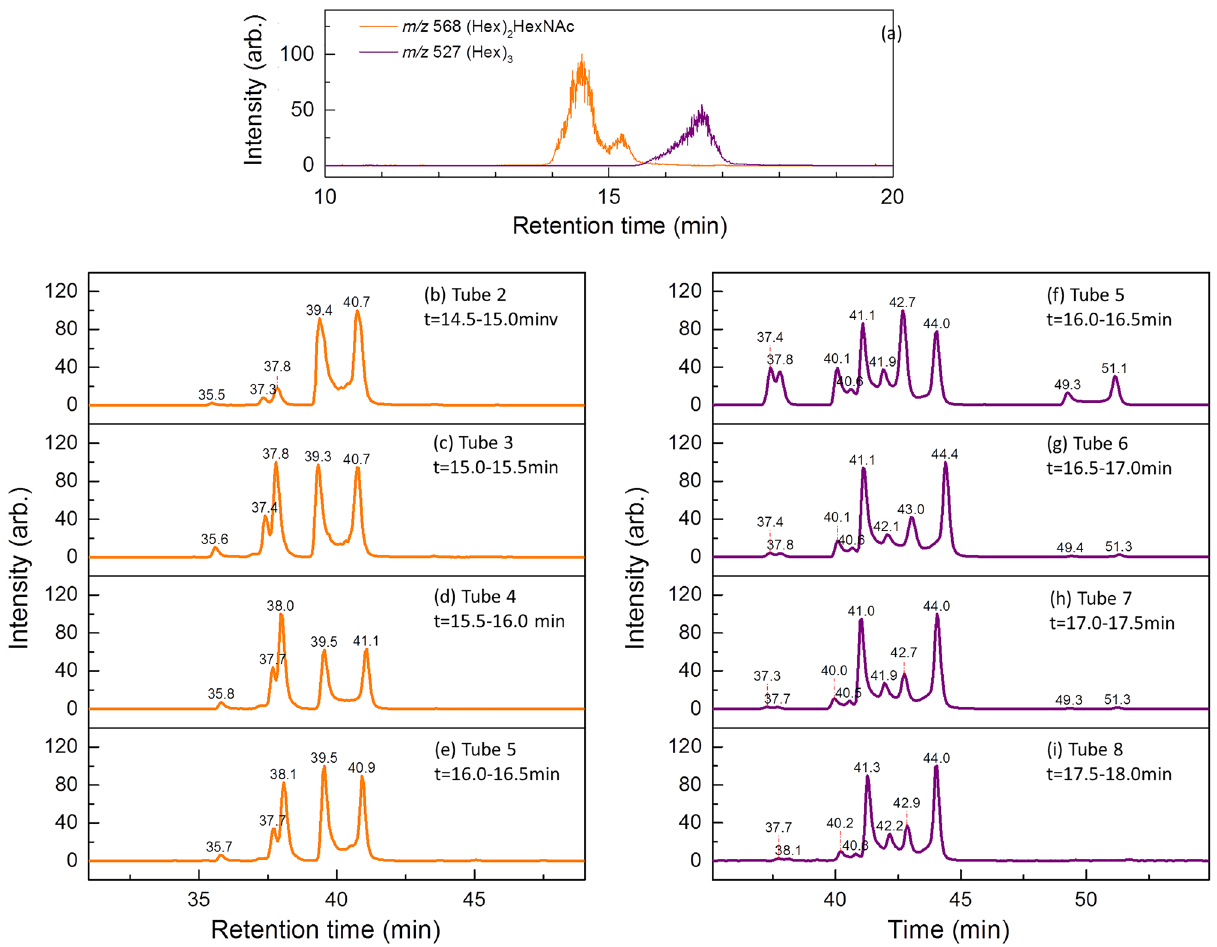
Figure 5. ( a ) Chromatograms of ions m/z 527, (Hex) 3 and 568, (Hex) 3 HexNAc, separated by HPLC with amide-80 column of bovine milk. ( b–e ): Chromatograms of ion m/z 568. ( f–i ): Chromatograms of ion m/z 527. In ( b–i ), the isomers in each fraction collected from the eluents of amide-80 column were separated by HPLC with PGC column. The duration that each fraction collected from the eluents of amide-80 column, corresponding to retention time in ( a ), is illustrated for each tube. Note that the absolute retention times are different from that of Figs. 1–4 because of different HPLC apparatus and different lengths of tubing in HPLC were